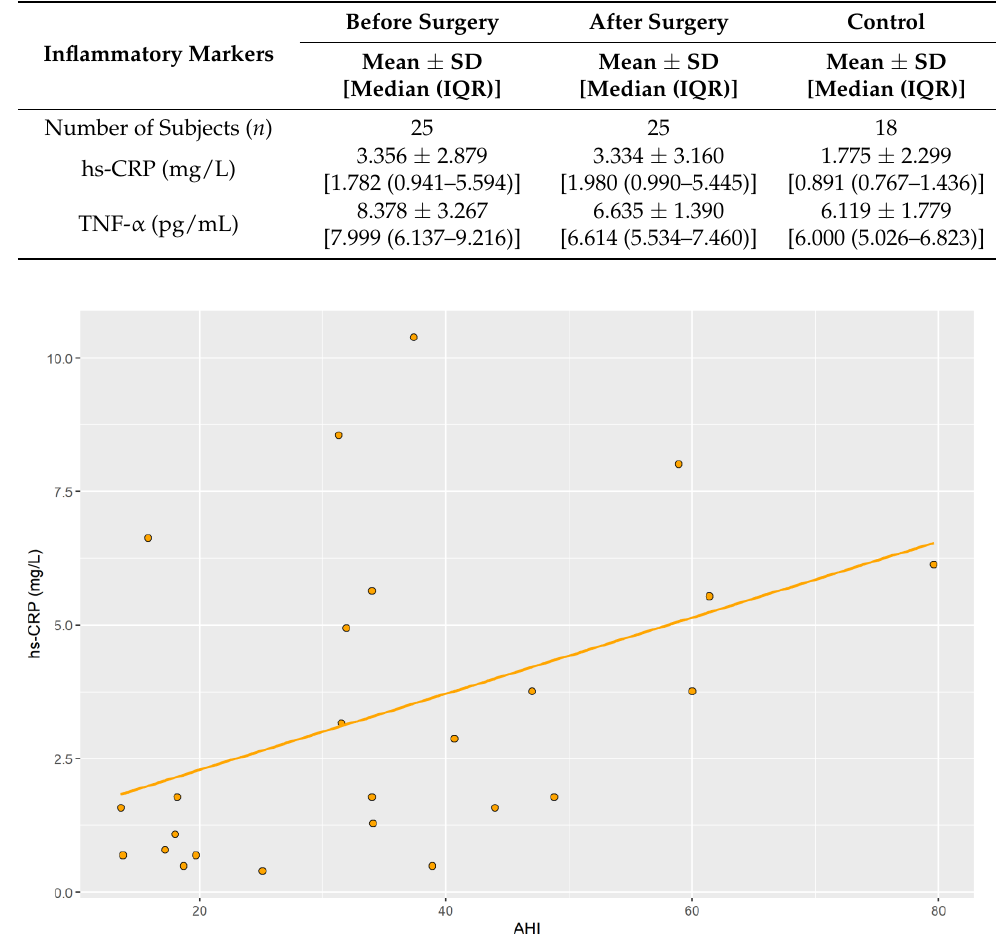
Figure 1. Correlation of AHI with hs-CRP levels in the pre-operative group. Table 2. Results as mean values and standard deviation (SD) and median values with interquartile range (IQR) of high sensitivity C-reactive protein (hs-CRP) and tumor necrosis factor-alpha (TNF- α) in the pre-operative group, post-operative group, and control group.